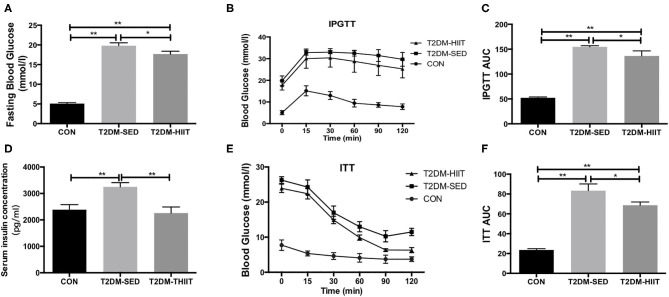
HIIT improves fasting blood glucose, glucose hemostasis and serum insulin in T2DM mice. (A) Fasting blood glucose, (B) Plots for glucose tolerance tests (IPGTT, 1 g/kg BW) in overnight fasted mice, (C) AUC values confirmed improvements of glucose tolerance in T2DM-HIIT group mice, (D) Serum insulin concentration, (E) Plots for insulin tolerance tests (ITT, 1 IU/kg BW) in mice fasted for 6 h, (F) AUC values confirmed improvements of insulin tolerance in T2DM-HIIT group mice. All data are presented as mean ± SEM. n = 11 per group; *p < 0.05, **p < 0.01.